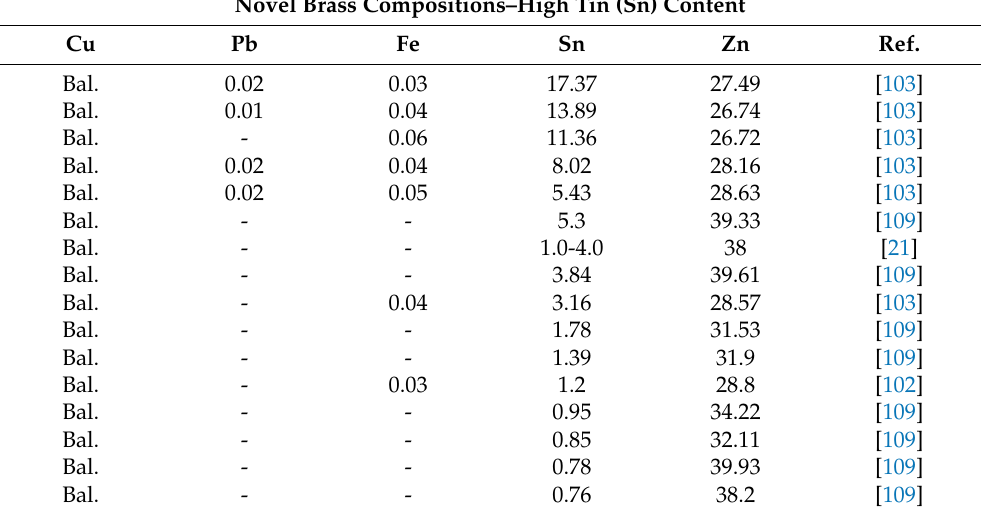
Table A5. Novel brass compositions with an increased tin (Sn) content (alloying elements expressed in wt.%).